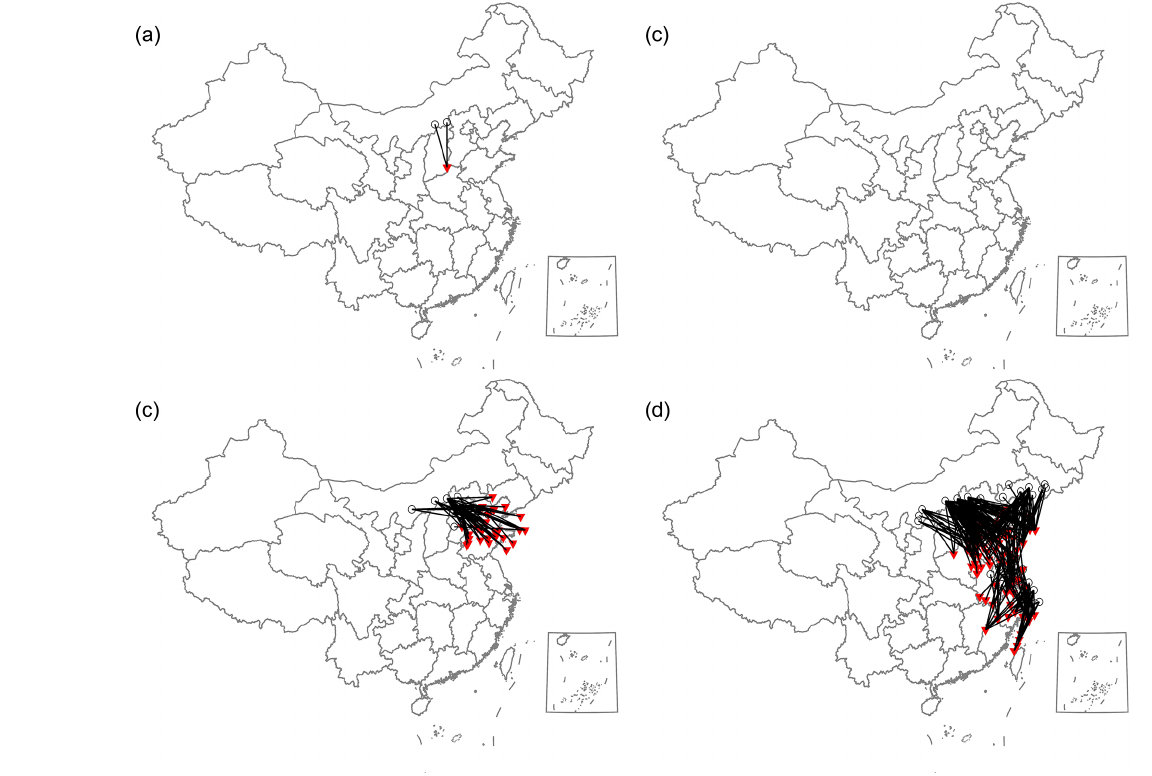
Figure 8. Distribution of transport paths in the network for spring (a) , summer (b) , autumn (c) , and winter (d) .